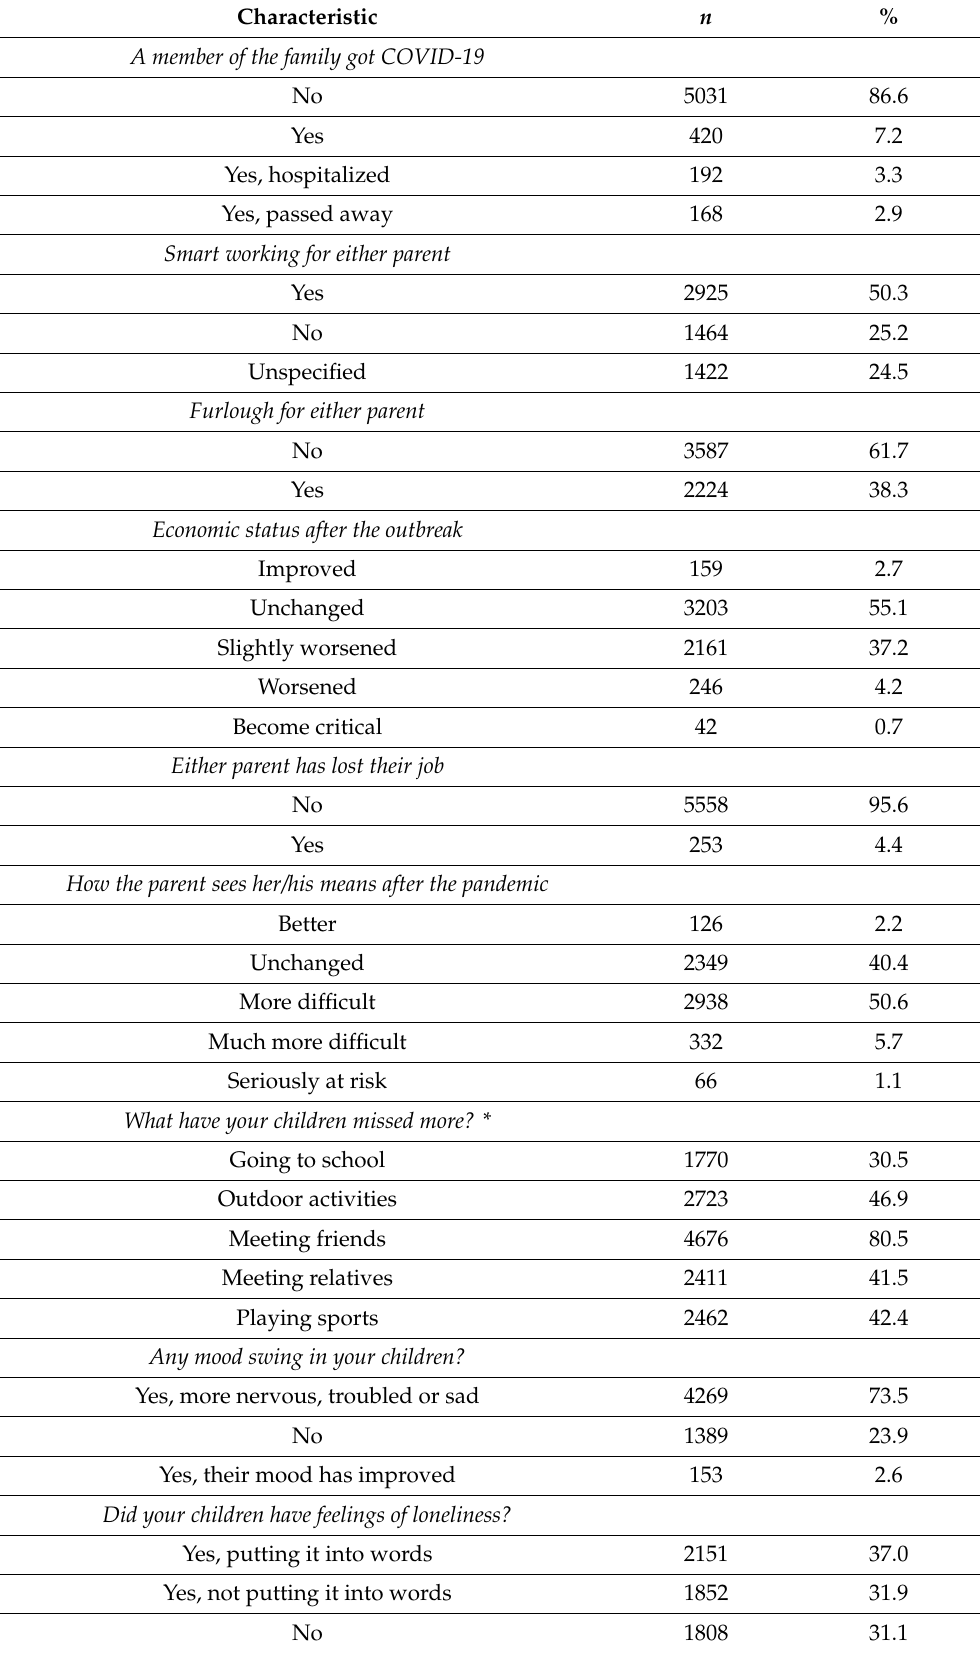
Table 2. Parents’ experience and attitudes toward the coronavirus pandemic ( n −